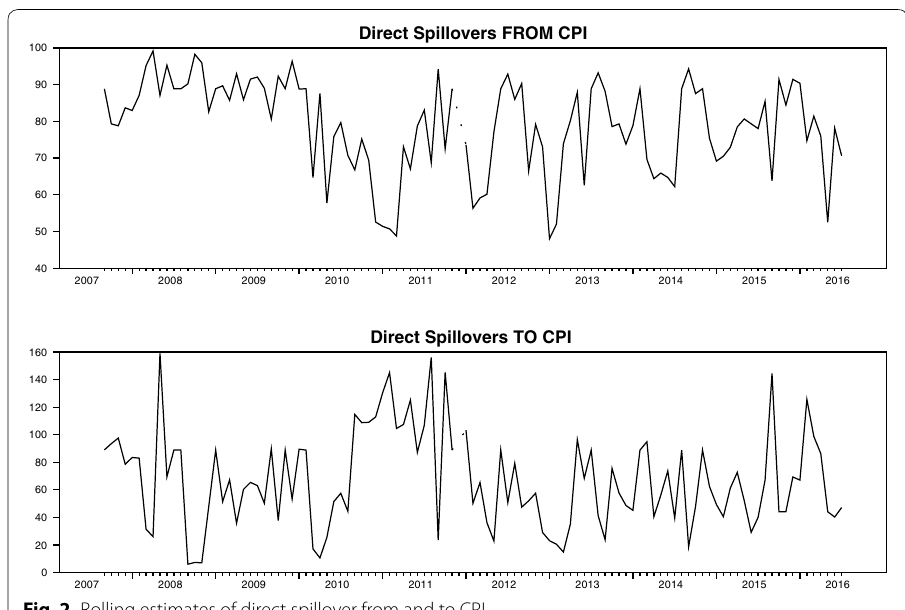
Fig. 2 Rolling estimates of direct spillover from and to